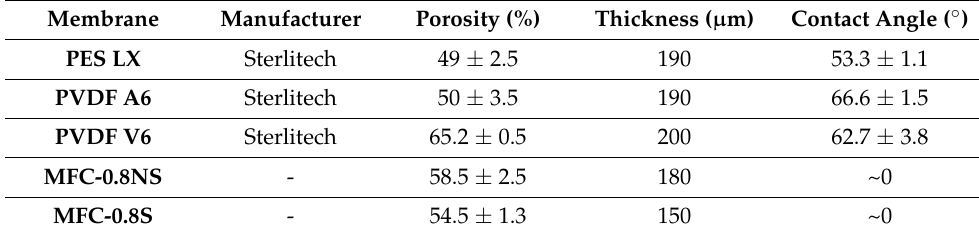
Table 3. Comparison of MFC and commercial polymer membranes.